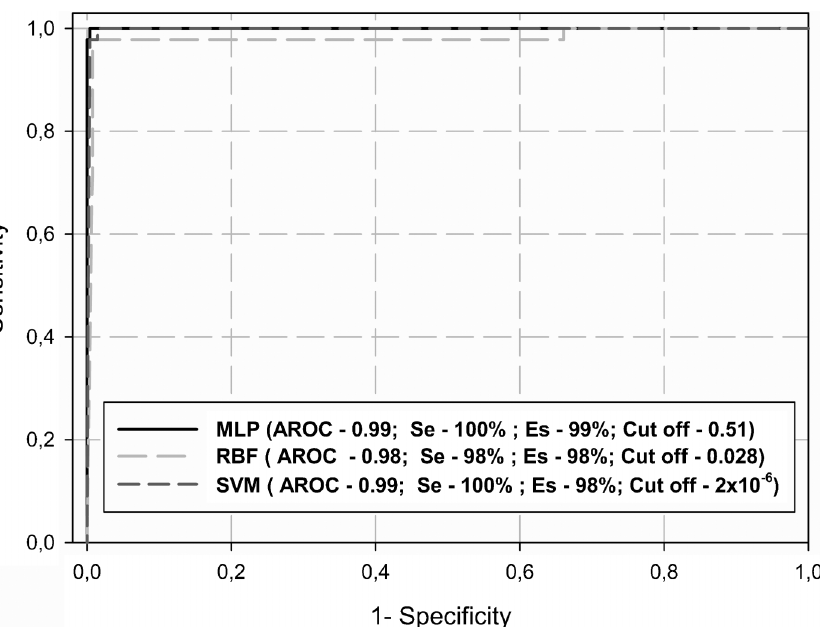
Figure 1 - ROC curves for detecting keratoconus apart from the other non-keratoconus patterns, computed for support vector machine(SVM), multi-layer perceptron (MLP) and radial basis function neural network classifiers (RBF). AROC, area under ther ROC curve; Se, sensibility; Es, specificity; cut off,